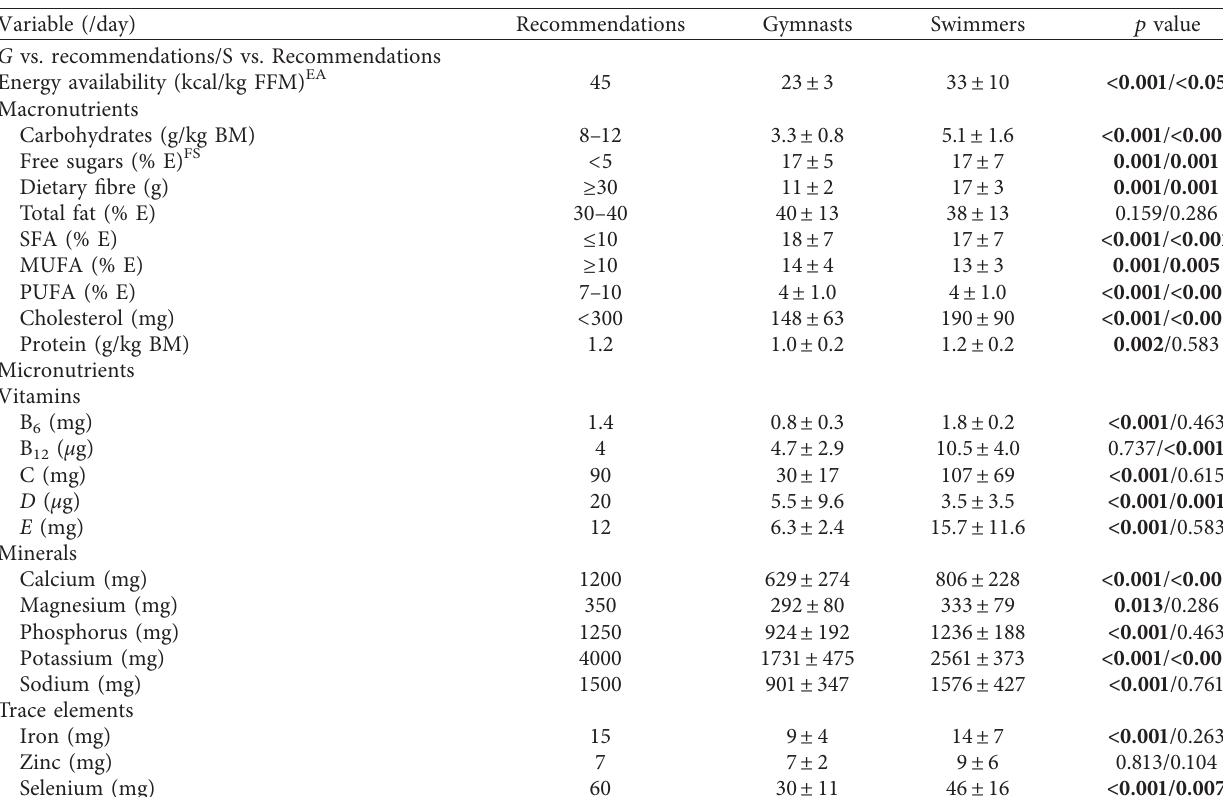
Table 2: Dietary intake among elite-level artistic gymnasts and swimmers gymnasts and swimmers compared with recommendations